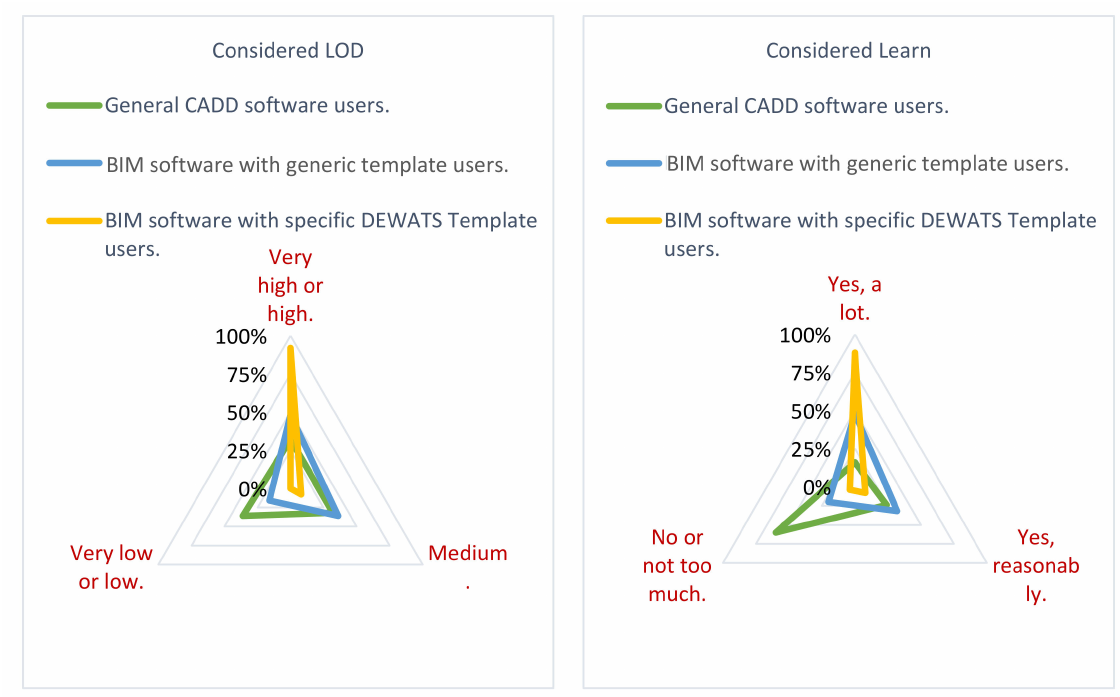
Figure 10. Comparison between answers to the fourth ( left ) and fifth ( right ) questions. Source: authors